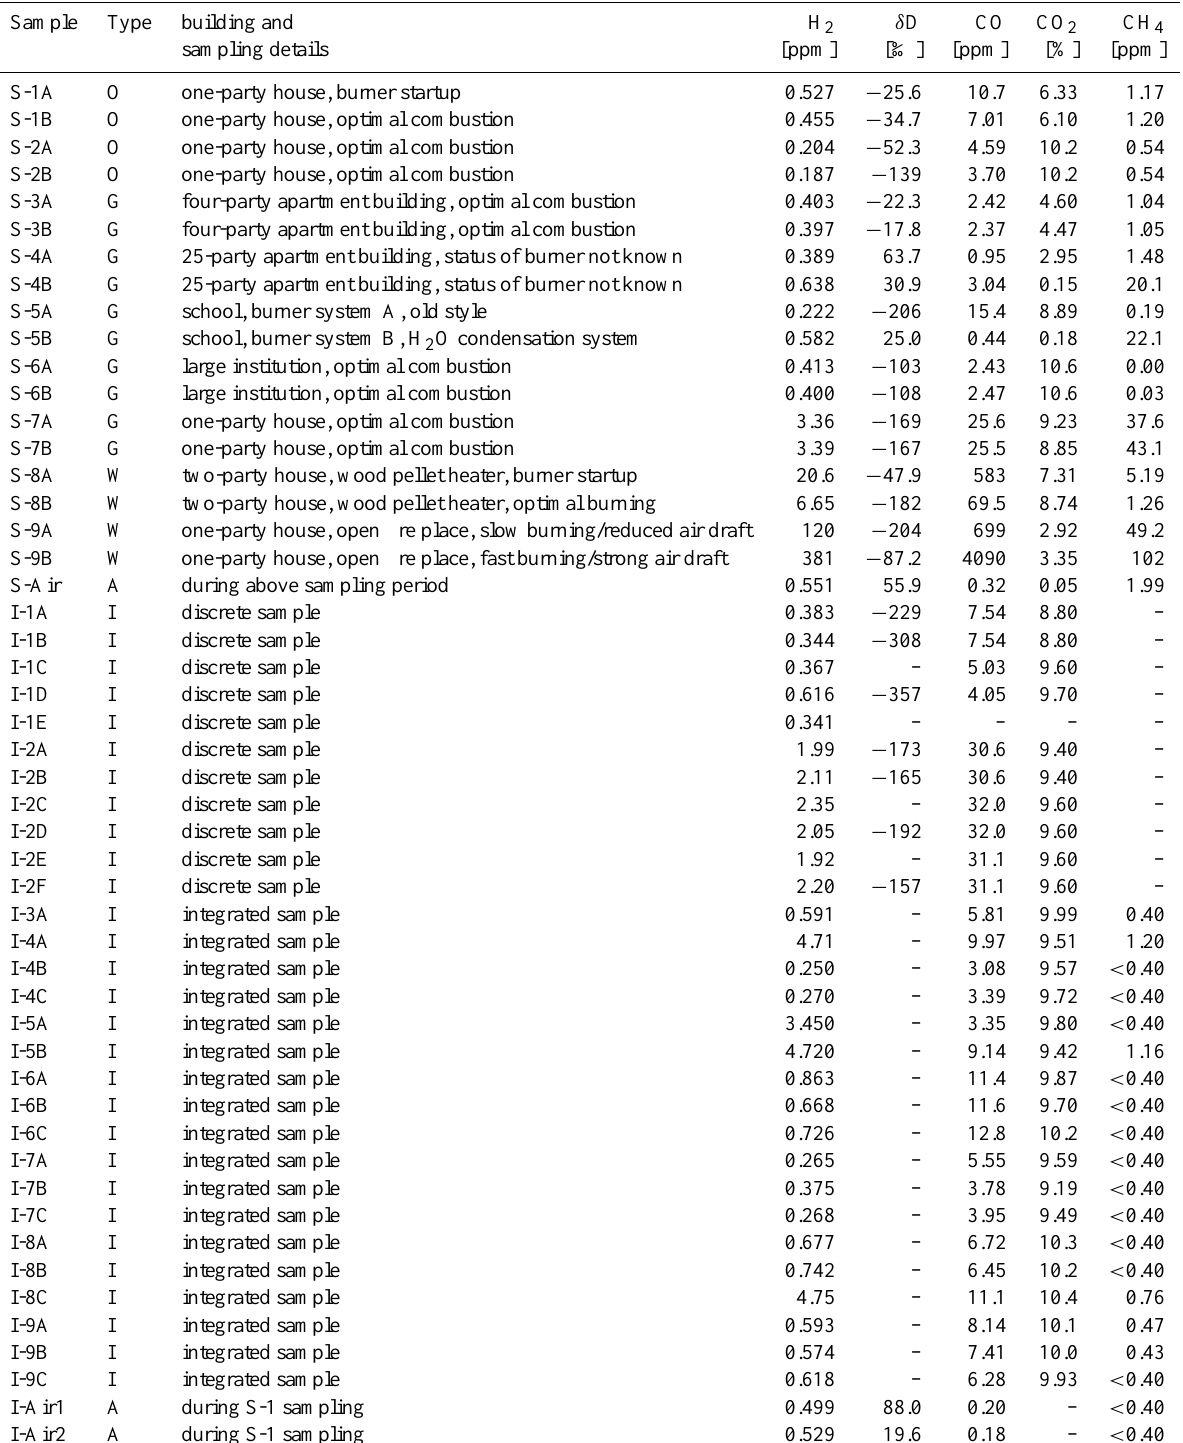
Table 2. Molecular hydrogen (H 2 ), its isotopic composition ( δ D), carbon monoxide (CO), carbon dioxide (CO 2 ), and methane (CH 4 ) in the exhausts of oil (O), gas (G) and wood (W) heaters, waste incinerators (I), and from ambient air samples (A). The incinerator samples are from 7 different incinerators (some measurement campaigns were repeated, hence 9 sets listed) and collected using discrete flask/bag or integrated (1 week) samples. S-Air and I-Air samples are ambient air samples collected during the study. Mole fractions (dry air) are given in ppm (10 − 6 ) for H 2 , CO, and CH 4 , and in percent (10 − 2 ) for CO 2 . For δ D, see